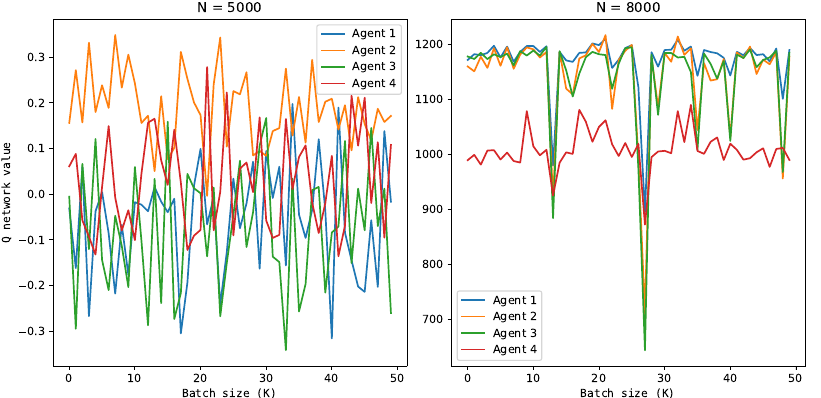
Figure 9. Q-network value considering the action taken from a continuous uniform distribution ( N = 5000) and the action with the MADDPG algorithm ( N = 8000).